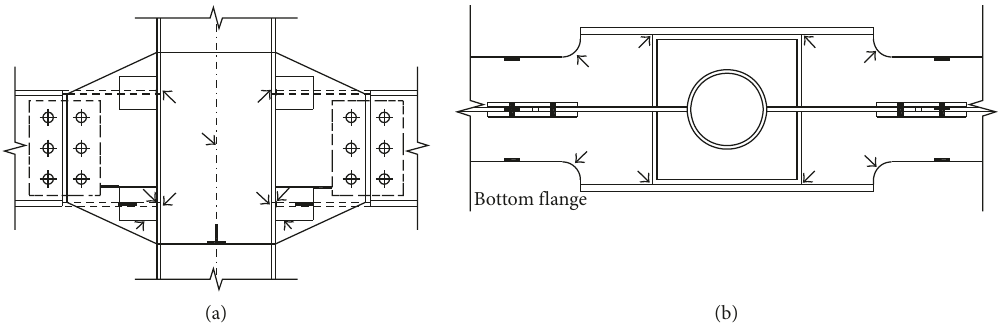
Figure 8: Arrangement of the strain gauges on the steel components: (a) placed on the stiffening plates and web plates; (b) placed on the flanges and end plates.